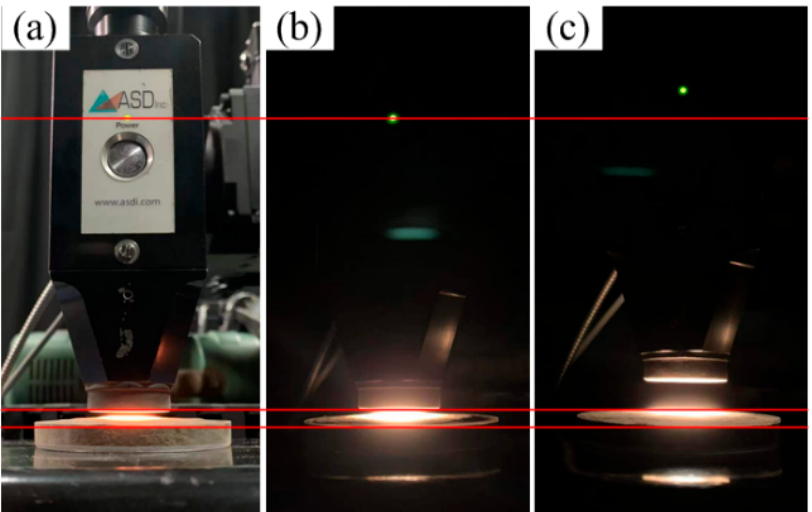
Figure 3. ( a ) Probe setup with 0.3 cm gap in illuminated room condition; ( b ) probe setup with 0.3 cm gap in darkroom condition; ( c ) probe setup with 1 cm gap in darkroom condition; three red lines of reference indicate the position change of the probe.